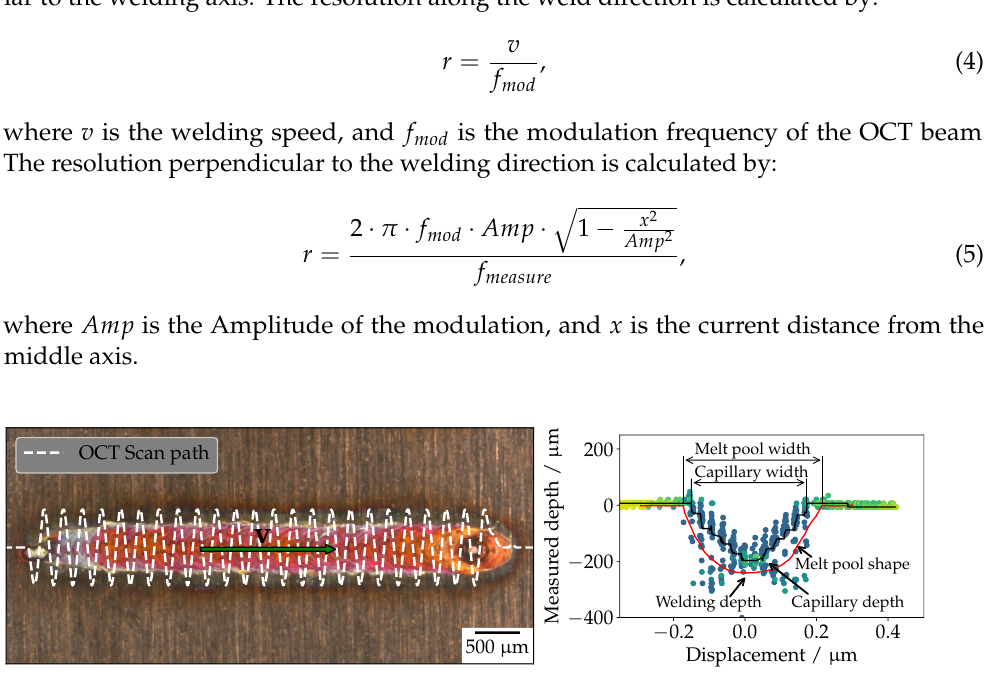
Figure 10a. The spatial resolution is now divided into the resolution along and perpendicu- lar to the welding axis. The resolution along the weld direction is calculated by: v , (4) r = f mod where v is the welding speed, and f mod is the modulation frequency of the OCT beam.